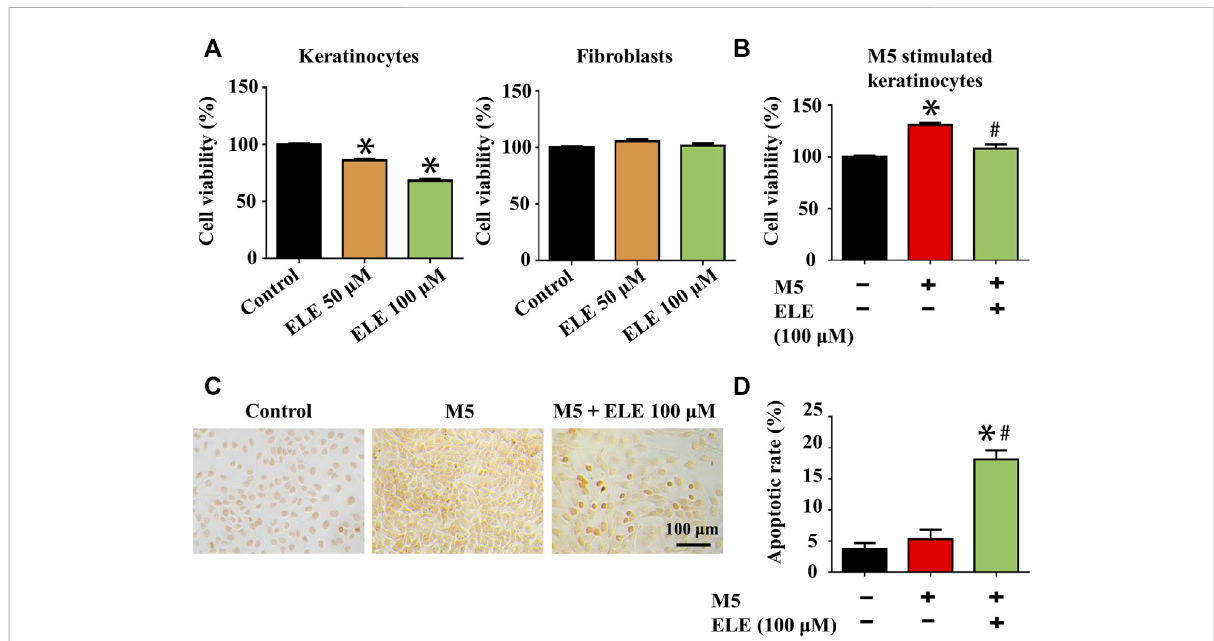
FIGURE 1 (A) Effects ofELEontheviability ofkeratinocytes and fi broblasts at72 h. (B) EffectsofELEontheviabilityofM5-stimulatedkeratinocytesat72 h (C) ELE-induced apoptosis cells (dark brown) detected in M5-stimulated keratinocytes using TUNEL assay. (D) Quantitative analysis of TUNEL assay. * p < 0.05 versus control, # p < 0.05 versus M5. Error bars indicate SEM ( n =